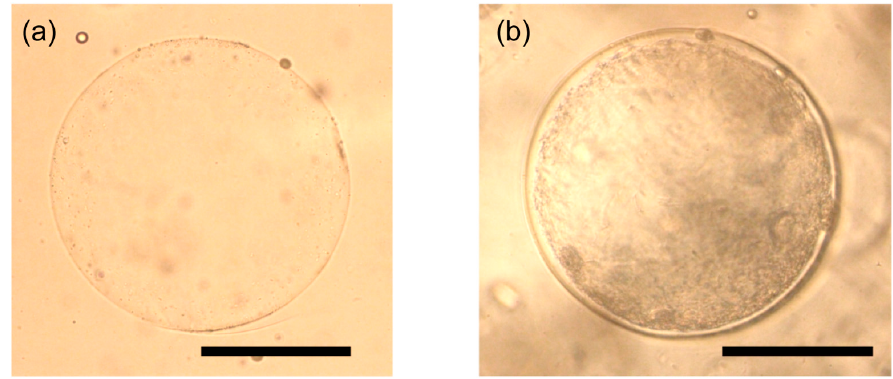
Figure 6. Micrographs of BC microspheres ( a ) at initial state, and ( b ) after 2 day cultivation. Scale bars, 200 µ m.